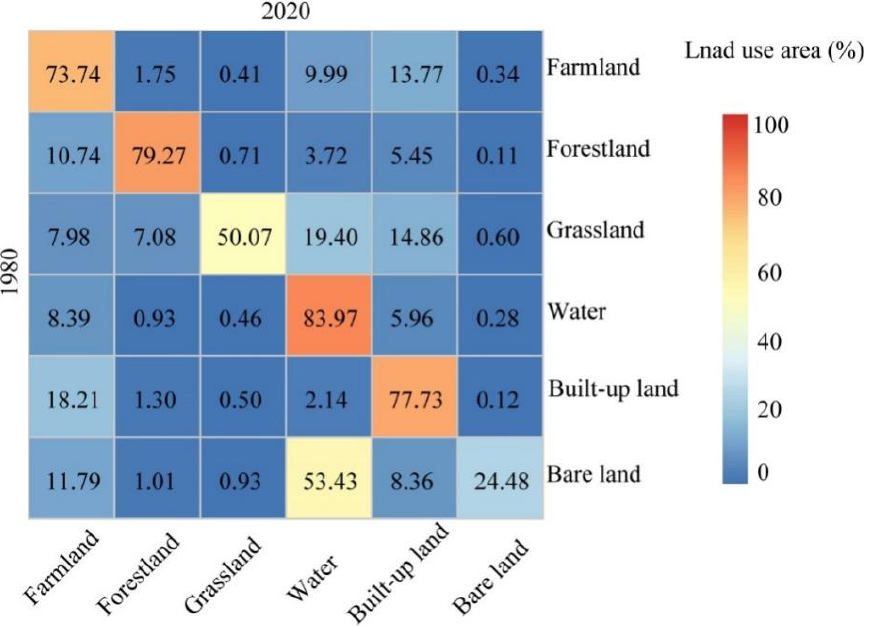
Figure 5. Landscape transformation (land use area %) of Wuhan city between 1980 and 2020. These data were derived from spatial distribution maps in 1980 and 2020. In each row, the numbers indicate the area percentage of a land use type (row header) converted to another type (column header) during the period, and the sum is 100. In each column, the data document a land use type (column header) that was converted from other types (row headers) during the period.